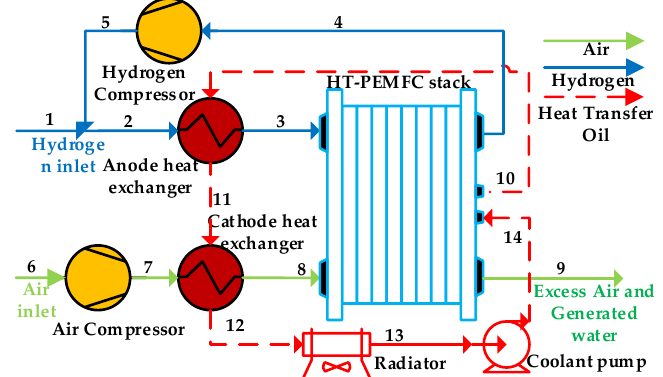
Figure 11. Schematic illustration of the HT-PEMFC system.